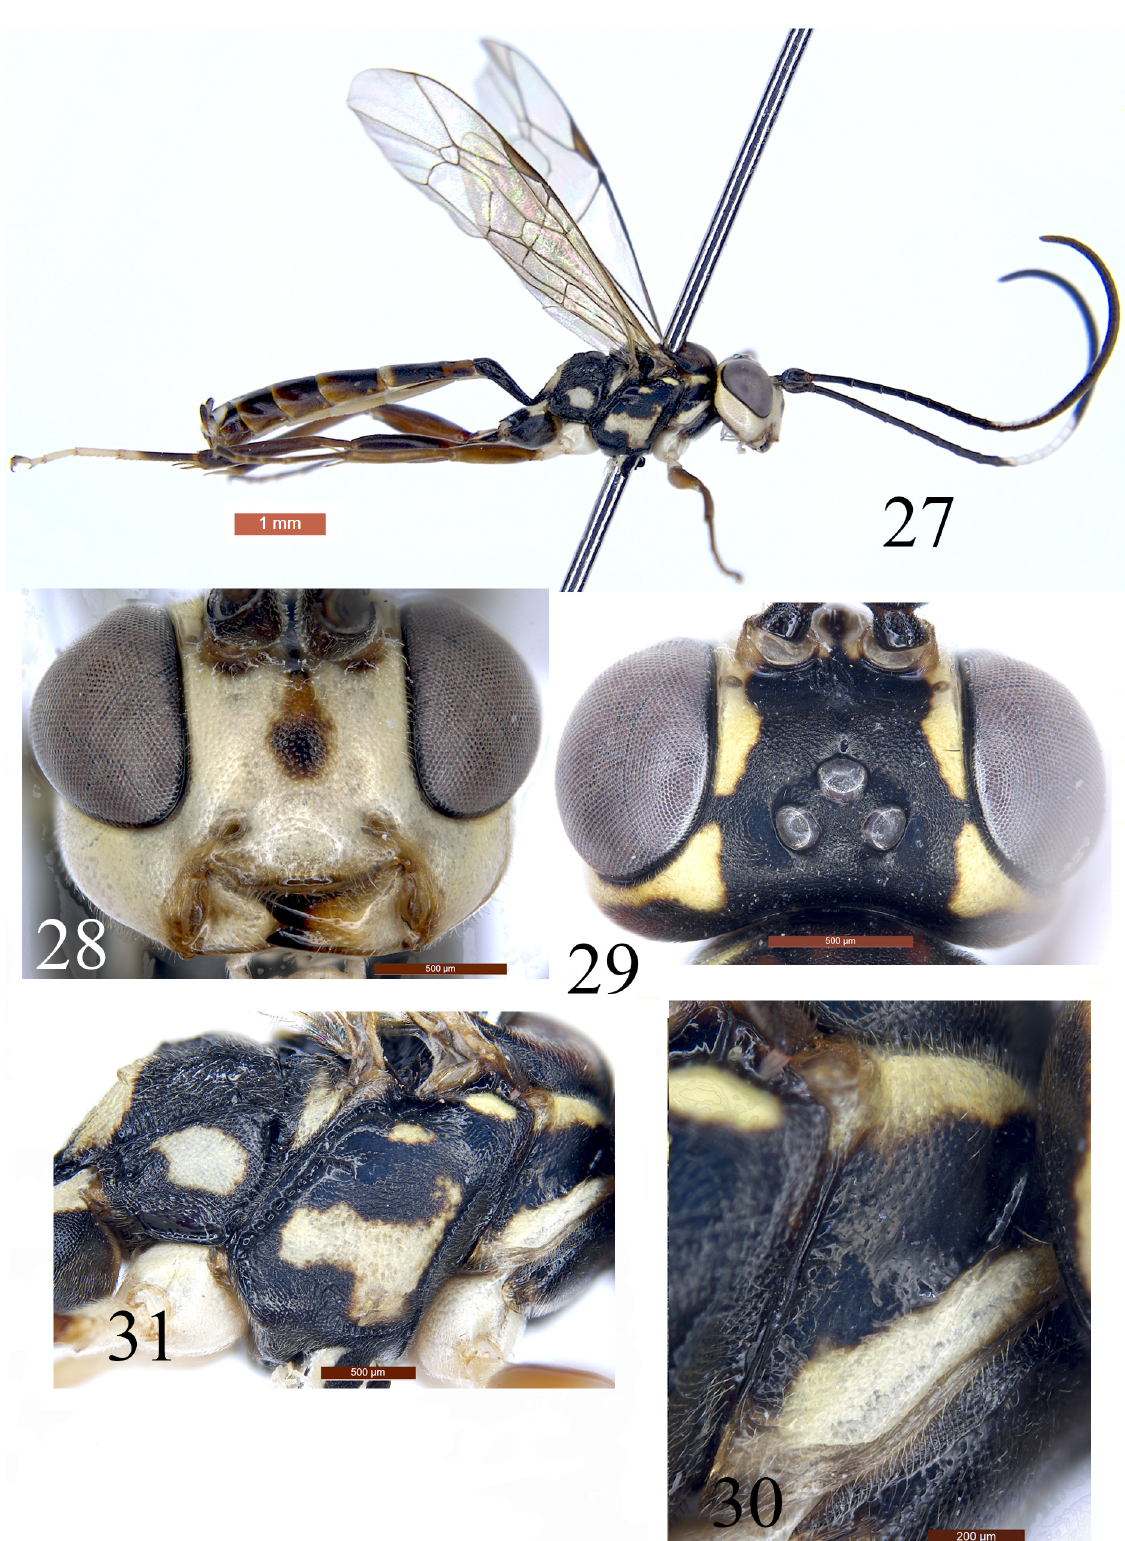
Figs 27–31. Notosemus wugongicus Sheng & Sun, sp. nov., holotype, ♀. 27 . habitus, lateral view. 28 . head, anterior view. 29 . head, dorsal view. 30 . Pronotum. 31 . Mesosoma, lateral